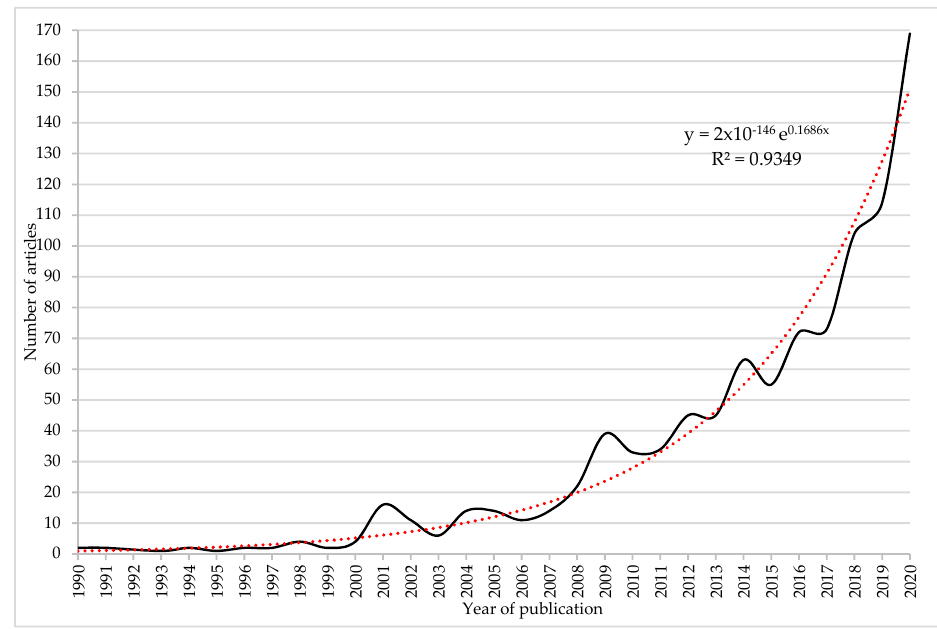
Figure 2. Progression of the number of published articles (1990–2020).